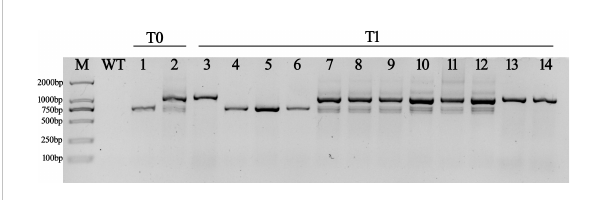
FIGURE 9 The RT-PCR products for the cDNA of the CA10g11690 in transgenic tobacco lines. WT: control tobacco line, 1: CaMV35S:: c690 Short-Chen12-4 T0-lines, 2: CaMV35S::c690 Long-Z101 T0-lines, 3: CaMV35S::c690 Short-Chen12-4 T1-lines with green phenotype, 4-6: CaMV35S::c690 Short-Chen12-4 T1-lines with purple phenotype, 7-12: CaMV35S::c690 Long-Z101 T1-lines with purple phenotype, 13-14: CaMV35S::c690 Long-Z101 T1-lines with green